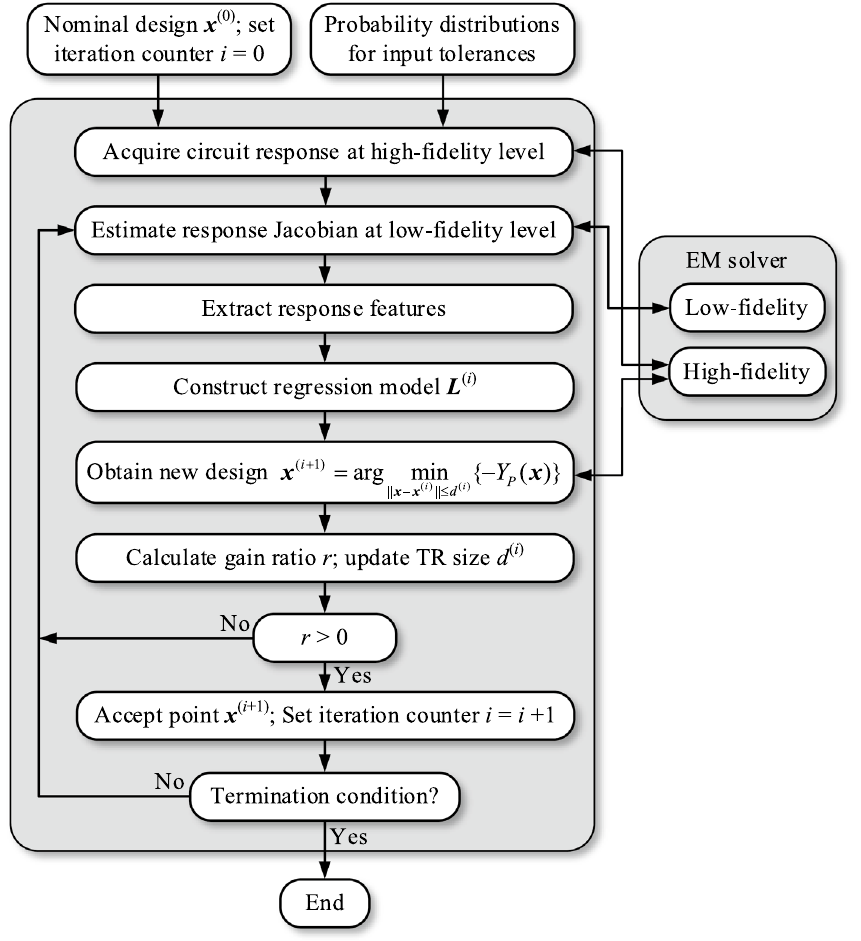
Figure 4. Flow diagram of the proposed yield optimization procedure.